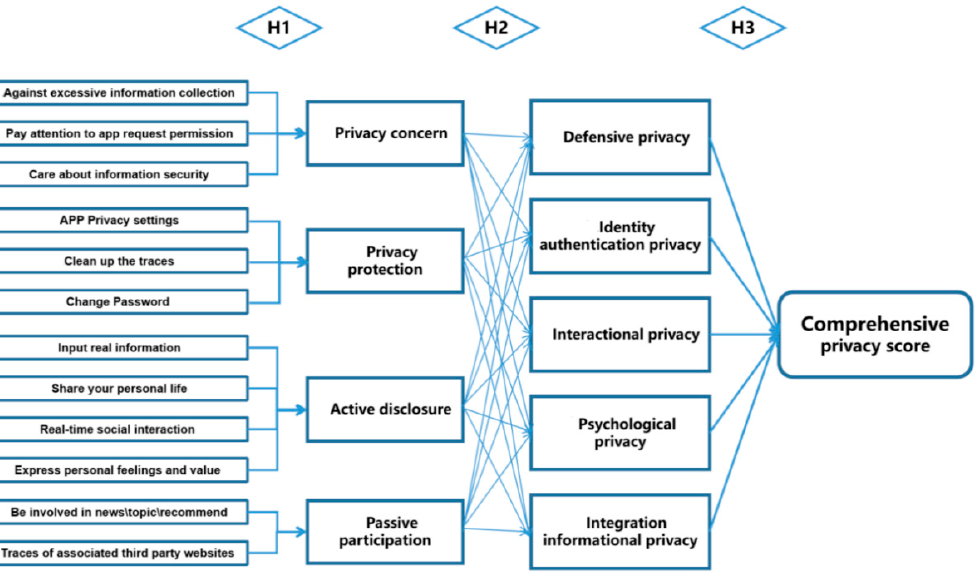
Figure 1. Research